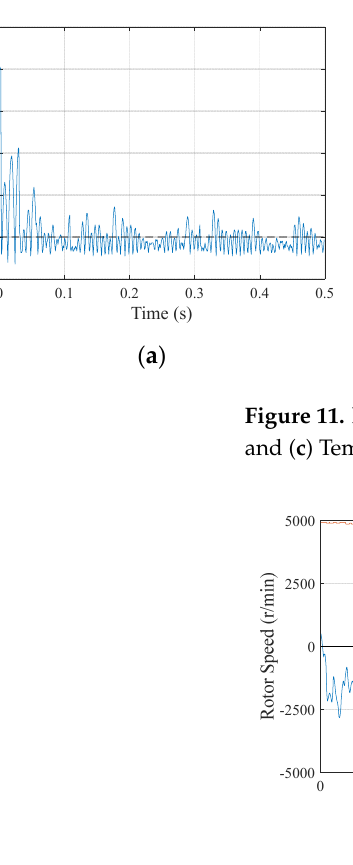
Figure 10. Whirl speed variation spectrum with initial touchdown speed.